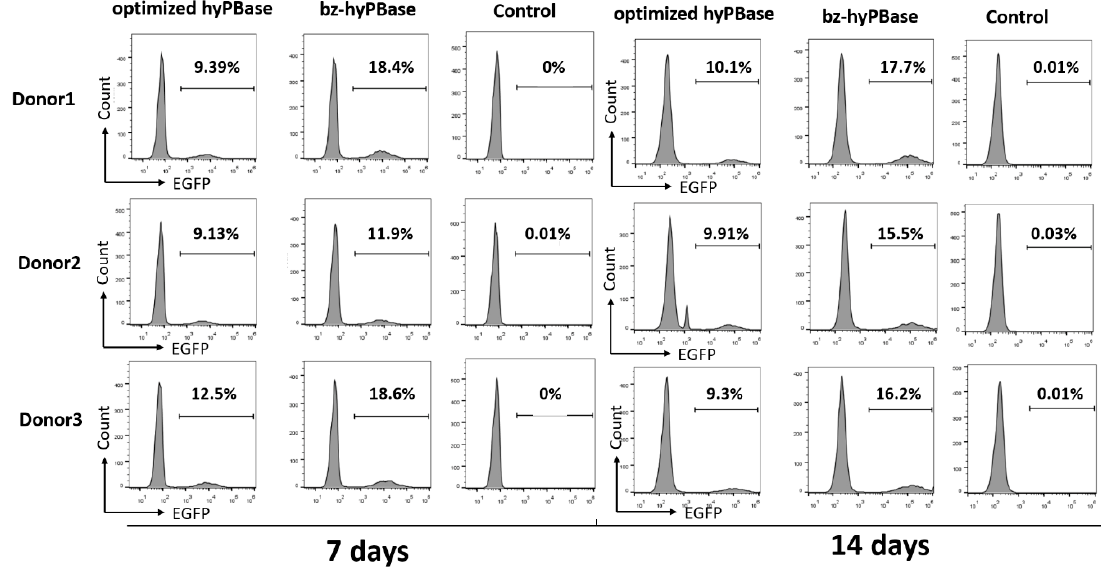
Figure 5. bz-hyPBase improved the editing efficiency in T cells. The two-plasmid transposon system (pLoxP-optimized hyPBase/pLoxP-mutant to express transposase, and pSAD-EGFP to express transposon) were coelectrotransformed into human T cells. After 7 and 14 days of culture, positive cells that completed gene transposition were measured by flow cytometry. On the right were the control cells containing the transposon plasmid pSAD-EGFP only. The X-axis represented the intensity of EGFP, and the Y-axis represented the number of cells. The values represented the percent of EGFP cells in each sample. The experiment was repeated by three groups T cells from three different donors.